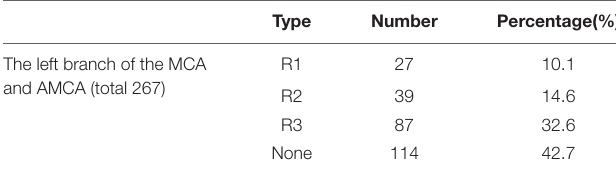
TABLE 2 | Distribution of the left branch of the MCA and AMCA.